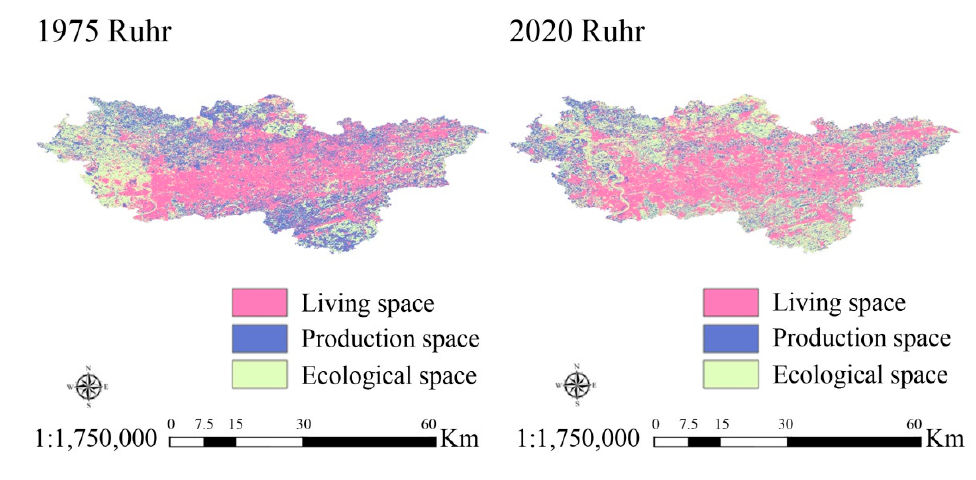
Figure 2. Results of PLES functions of five cities based on remote sensing image data (( a ).